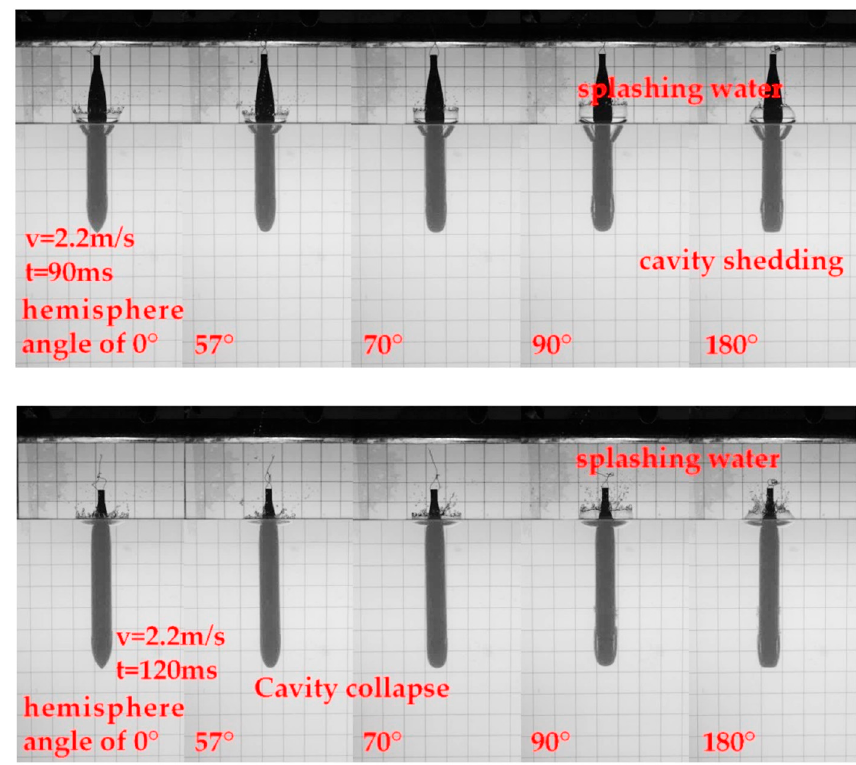
Figure 14. Experiment diagram of model entering water at a speed of 2.2 m/s.